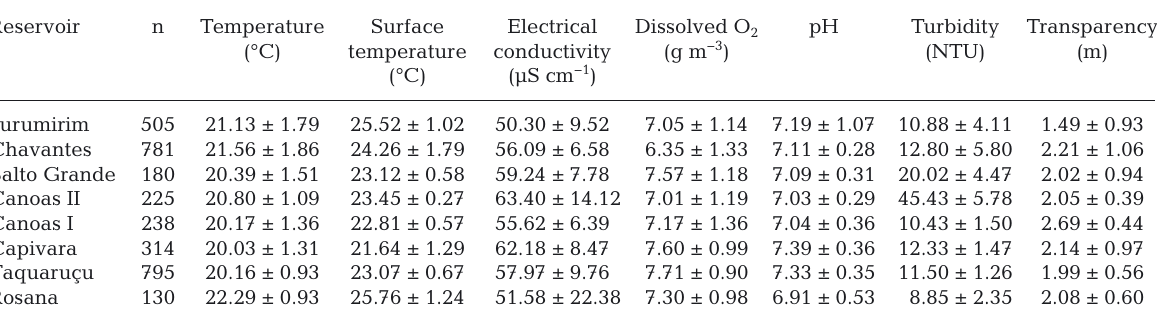
Table 8. Mean ± SE water physico-chemical characteristics of the Paranapanema River artificial reservoirs according to his - torical data. Mean temperature was measured for water samples collected at any depth, whereas mean surface temperature was measured at depths up to 2.5